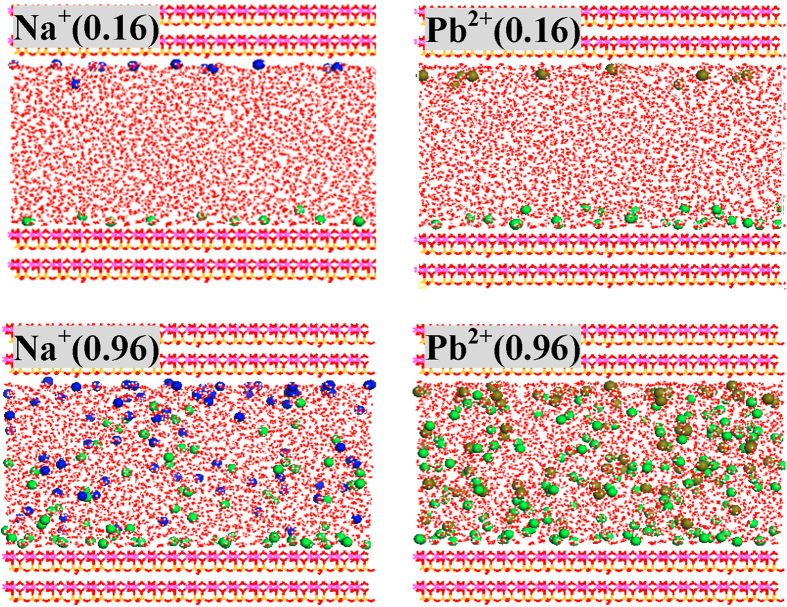
Configurations of defective kaolinite (Si1) in equilibration with 0.16 and 0.96 mol/L NaCl/PbCl2 solutions.Ionic concentrations (mol/L) are indicated in the parentheses of legends. Na+, Pb2+ and Cl− ions are represented as blue, dark yellow and green balls, respectively.